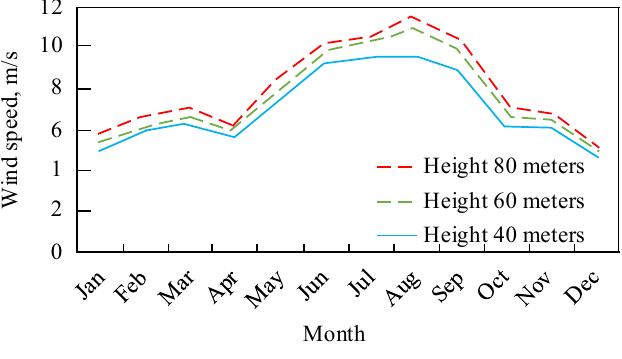
Fig. 3. Average monthly wind